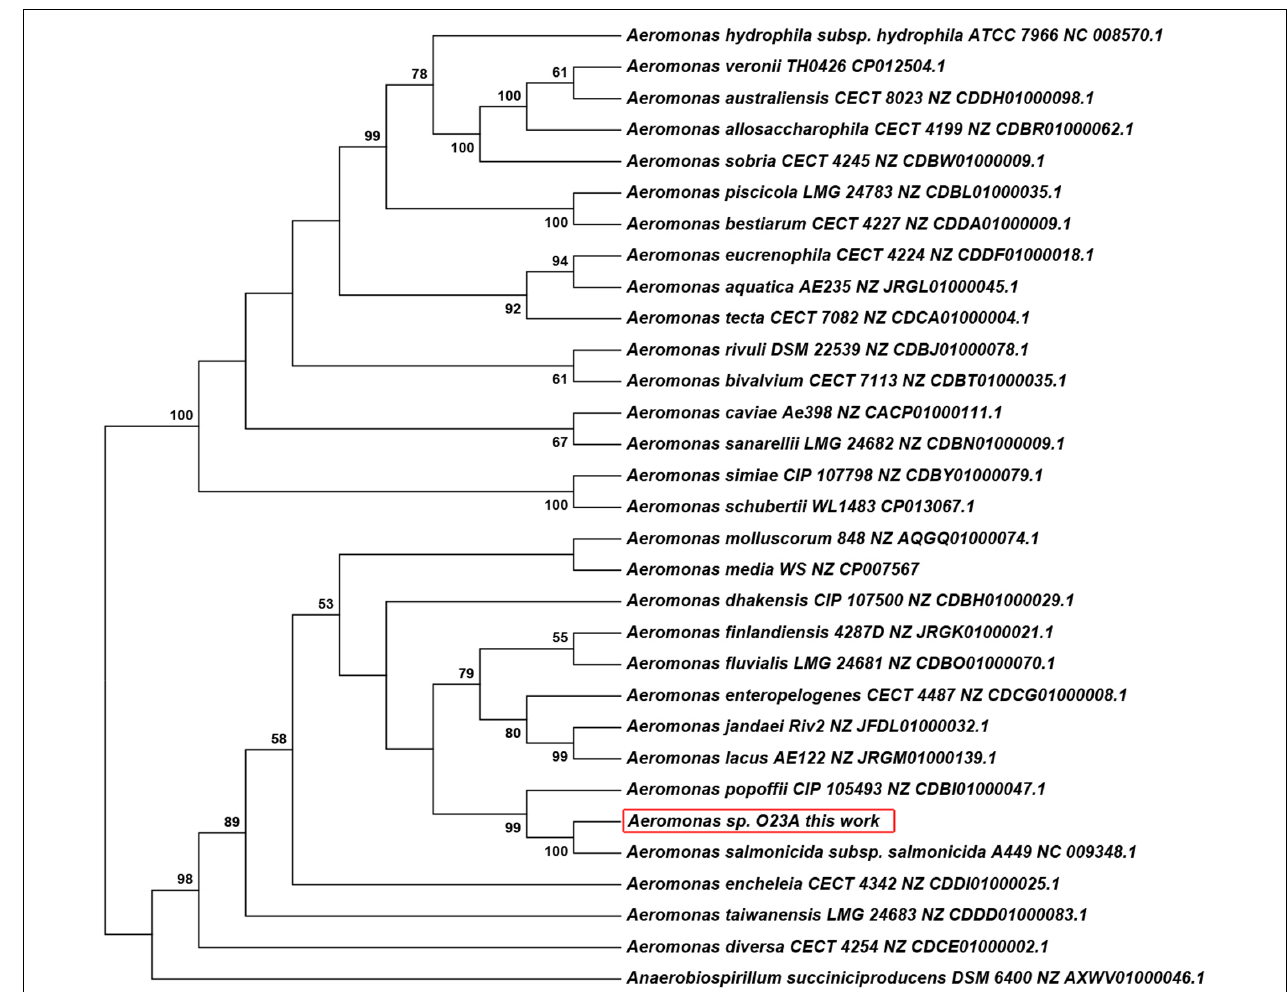
FIGURE 2 | Phylogenetic tree of Aeromonas spp. based on the rpoB genes sequences of 30 validly assigned representatives of this genus. The strain O23A analyzed in this work was indicated with a red frame. The rpoB gene sequence of Anaerobiospirillum succiniciproducens was used as the root. Accession numbers of the gene sequences used for the phylogenetic analysis are shown. The percentage of replicate trees, in which the associated taxa clustered together in the bootstrap test (1000 replicates) are shown next to the branches. Only values > 50% are